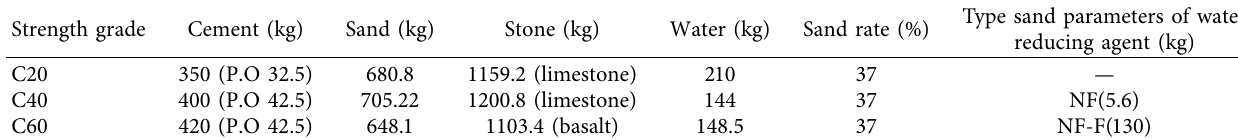
Table 3: Concrete mix